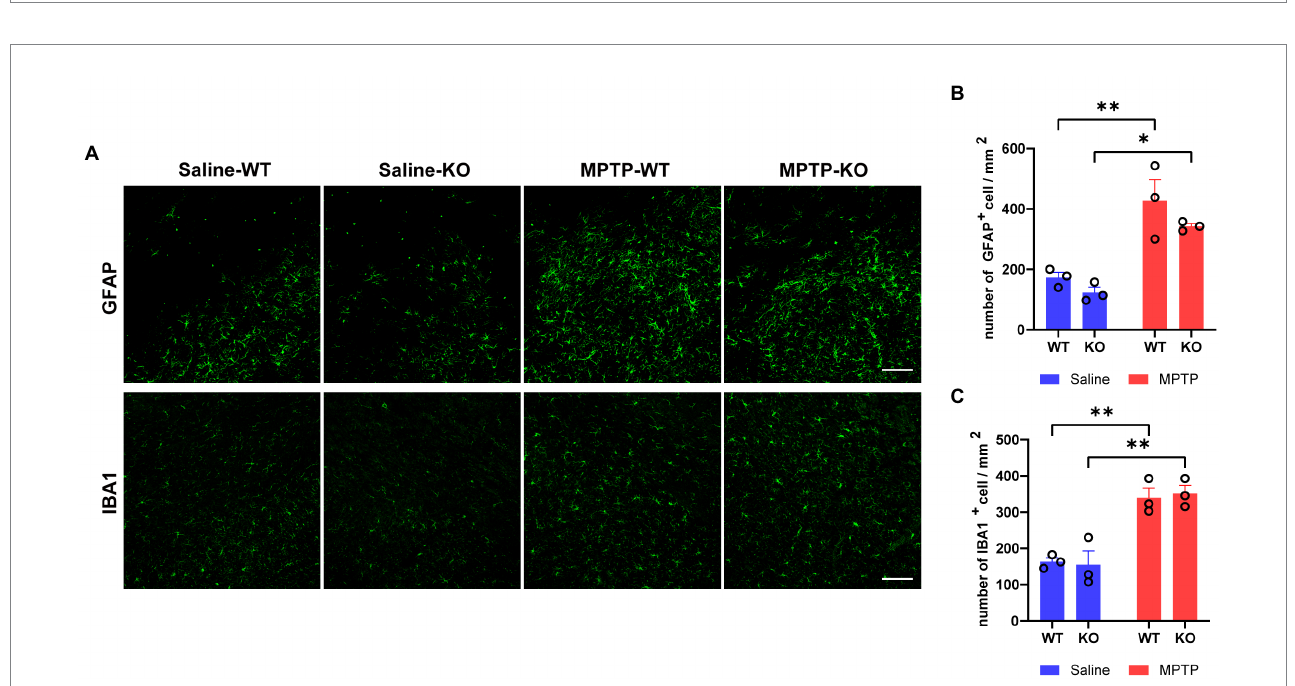
FIGURE 4 Loss of Rab39b does not alter reactive gliosis in SNpc of MPTP-induced mice. (A) Representative images of GFAP and IBA1 immunostaining of SNpc in MPTP-treated Rab39b KO and WT mice or respective saline-treated control mice. Scale bars, 100 μ m. (B) Quantitative analysis of GFAP-positive cells in (A) . (C) Quantitative analysis of IBA1-positive cells in (A) . n = 3 mice per group, average of 2–3 brain slices from each mouse. Data represent mean ± SEM, * p < 0.05, ** p < 0.01, two-way ANOVA followed by Tukey’s post hoc test.